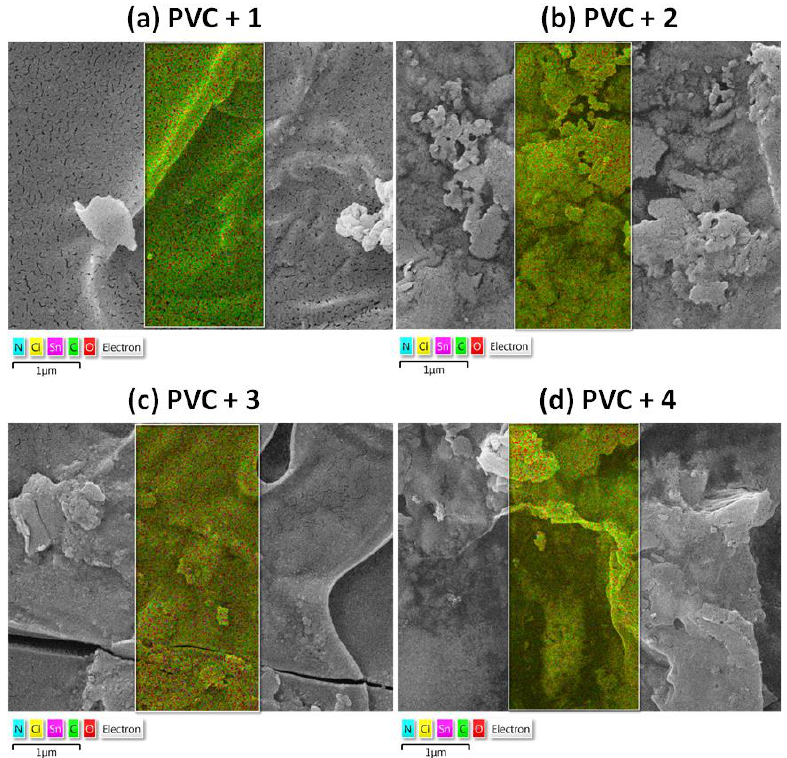
Figure 2. EDX mapping for PVC films: ( a ) PVC + 1 , ( b ) PVC + 2 , ( c ) PVC + 3 , and ( d ) PVC + 4 .